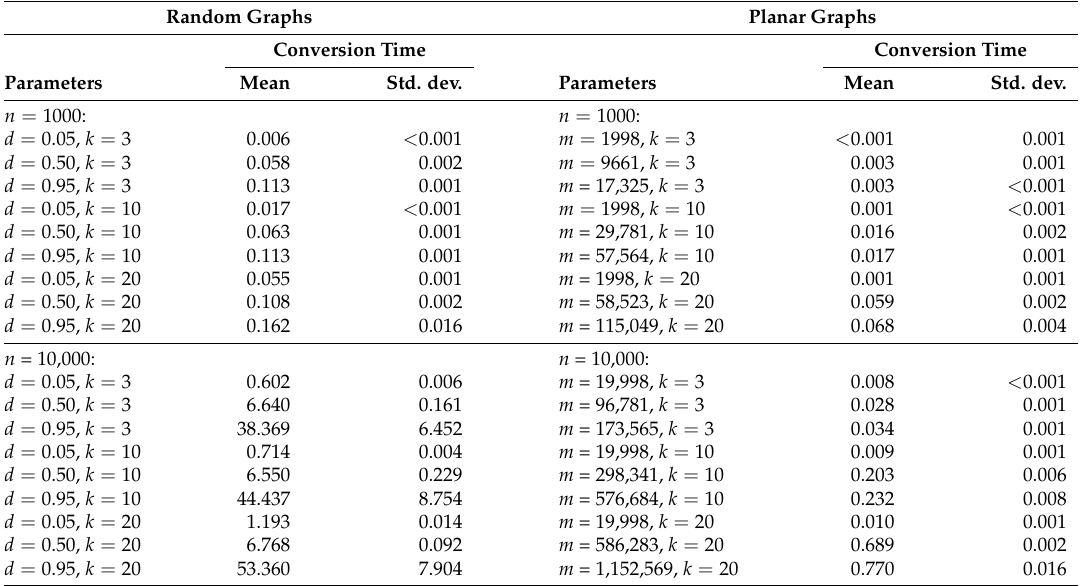
Table 3. Number of seconds to perform Kirby-Potts expansions for random and planar graphs of differing parameters. Figures show the mean and standard deviation across twenty problem